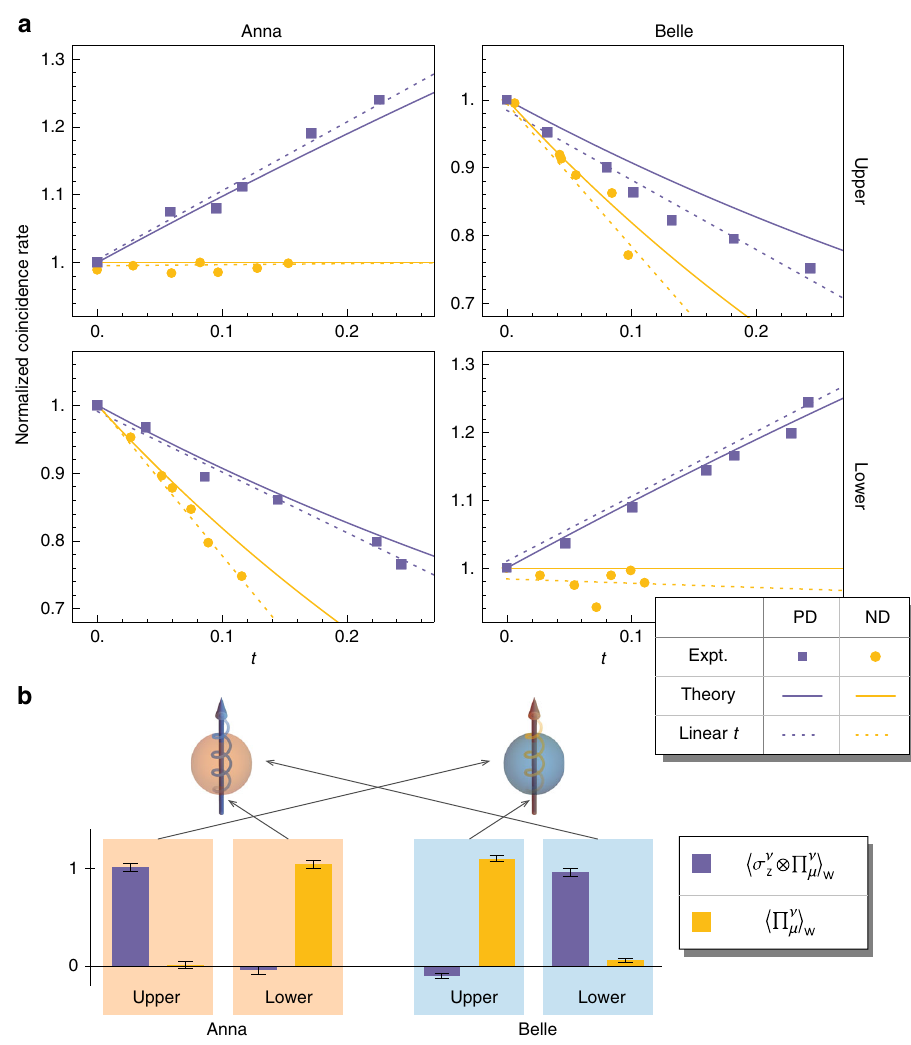
Fig. 3 Experimental results. a Recorded data with linear fi tted model and theoretical curve of the counting rates normalised with respect to when no fi lters are inserted, plotted against the interaction time of the attenuators in four arms of the interferometer. The data and curve with violet colour represent the case of ND fi lter insertion, and marigold colour for the case of PD fi lter. The error bars, calculated assuming Poissonian counting statistics, are smaller than data points and thus not shown. b Weak values calculated from the slope of the linear fi tted models and an illustration of the photons swapping their spins. Given the calculated weak values for each port, the implication is that Anna ʼ s photon is in the lower port but the spin is measured in the upper port, and vice versa for Belle. Consequently, on the beam splitter, Anna receives Belle ʼ s grin when the two lower paths converge. Similarly, Belle captures Anna ʼ s grin on the intersection of two upper